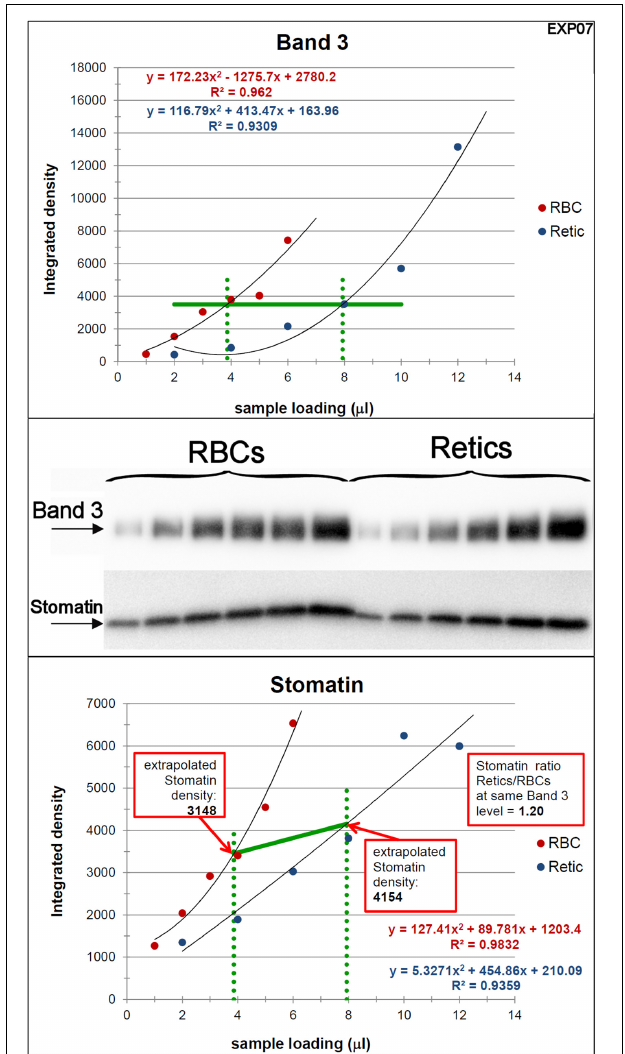
FIGURE 4 | Quantification of the relative amounts of stomatin with respect to Band 3 in Retics and RBCs. The same procedure adopted for flotillin-2 was performed to quantify the levels of stomatin in Retics and RBCs from the same donor. See legend to Figure 3 for